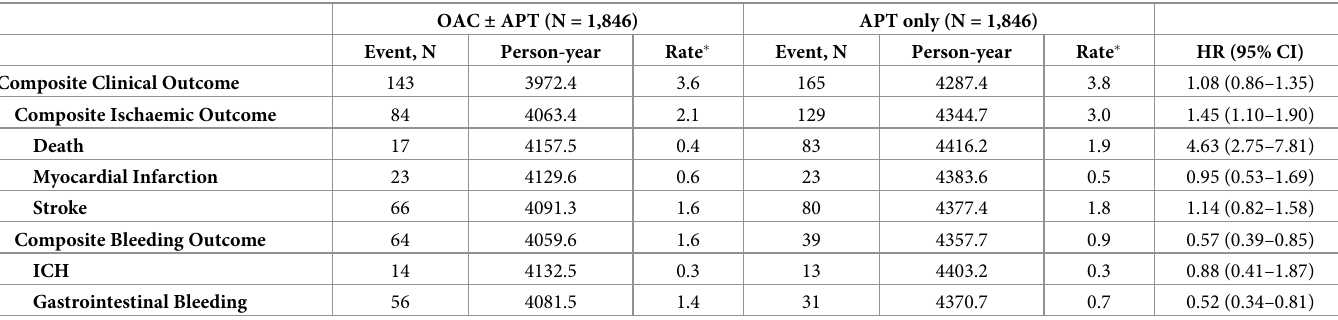
Table 2. Clinical outcome according to OAC prescription at 1-year after PCI.